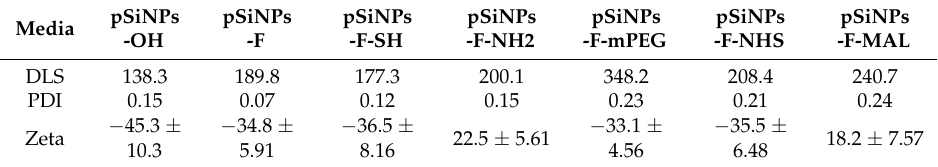
Table 1. DLS/PDI and Zeta-potential of the pSiNPs samples. 1 PDI: poly dispersity index.